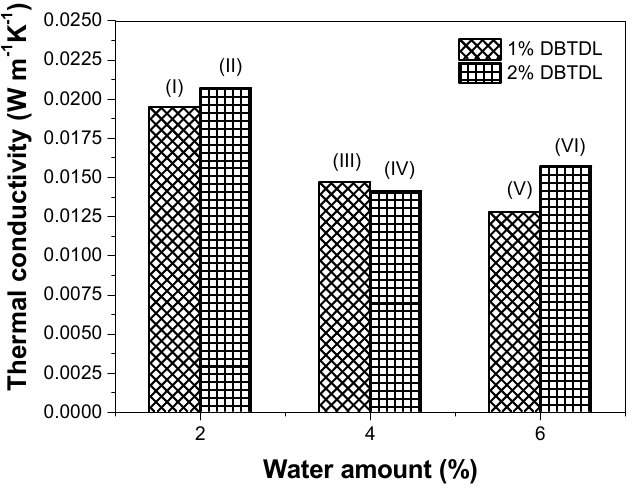
Figure 7. Thermal conductivity of foams with different contents of blowing agent (water) and catalyst (DBTDL). The numbers of foam formulations (Table 1) are indicated in each bar of this graphic.